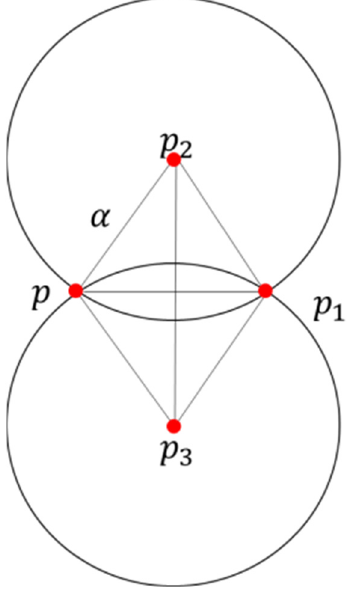
Figure 16. Alpha-shapes calculation schematic.